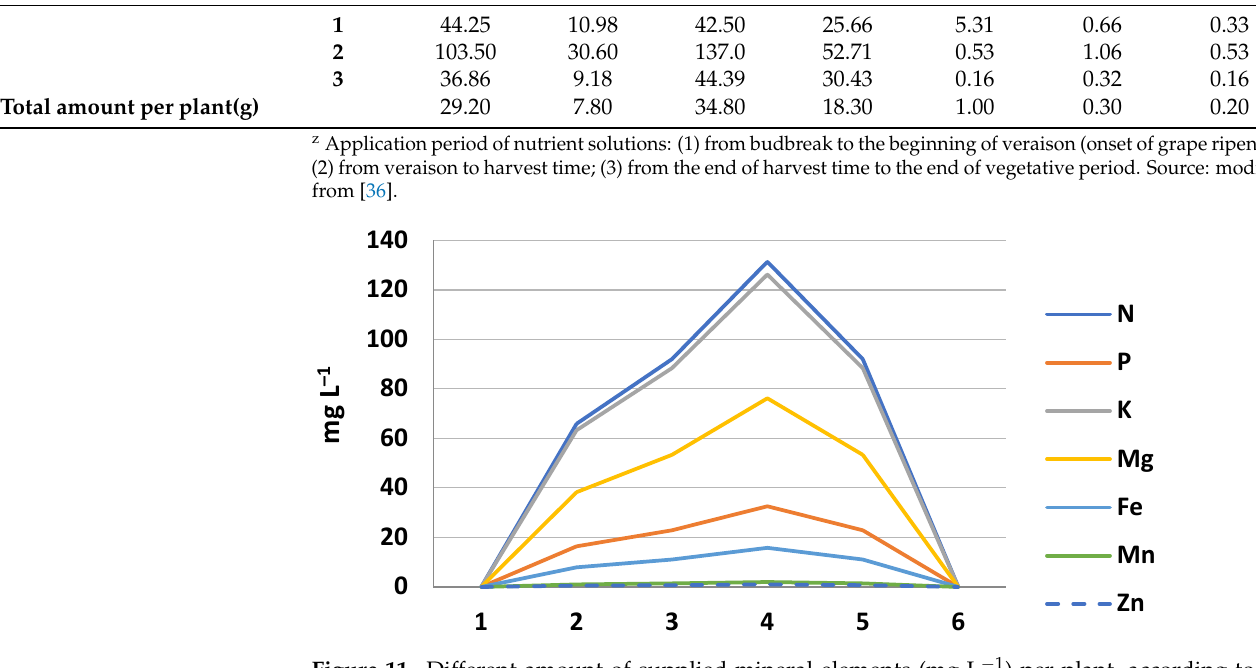
Figure 11. Different amount of supplied mineral elements (mg L − 1 ) per plant, according to the different phenological stages of growing cycle. Stage (1) until budbreak; (2) from budbreak to flowering; (3) from flowering to the beginning of veraison; (4) from veraison to harvest time; (5) from the end of harvest time to the end of vegetative period; (6) from the end of vegetative period onward. Source: modified from [36]. Table 11. Number and frequency of irrigations, and amount of water supplied per period and per plant (minimum and maximum values) z .